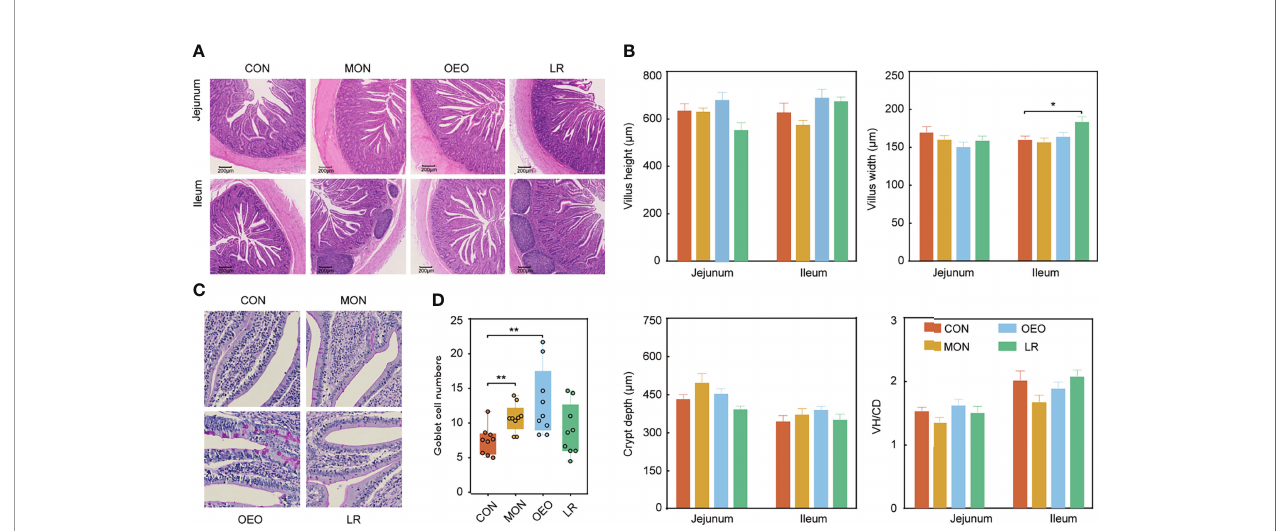
FIGURE 2 | Effect of OEO and LR on intestinal morphology of jejunum and ileum in sheep (A, B) and jejunal goblet cell numbers (C, D) . VH/CD: villus height to crypt depth ratio. Results are means ± SEM (n = 9/group). CON, a basal diet; MON, a basal diet plus 0.5 g/head/d monensin; OEO, a basal diet with 52 mg/head/d oregano essential oil; LR, a basal diet supplemented with 10 g/head/d Lactobacillus reuteri. Asterisks indicate signi fi cant difference between the trial group and the CON group (*0.01 < P ≤ 0.05; **0.001 < P ≤ 0.01; *** P ≤ 0.001).